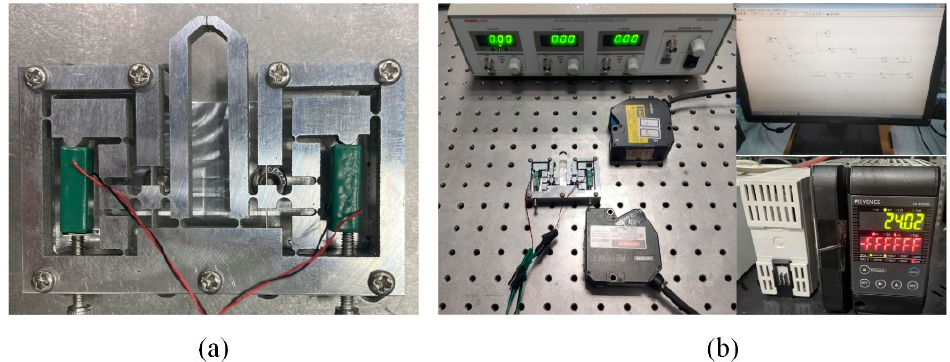
Figure 4. ( a ) The prototype of the proposed microgripper, ( b ) the experimental setup of the microgripper testing system.